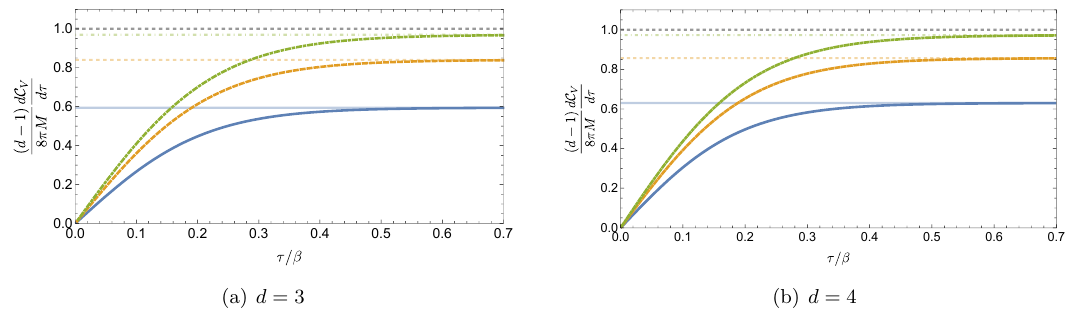
Figure 24 . Plots of d (cid:0) 1 d C V =dt for spherical black holes ( k = 1) for various values of the horizon 8 (cid:25)M radius | r h =L = 1 (blue), r h =L = 2 (yellow), r h =L = 5 (green). At late times, they approach to the asymptotic values indicated in (cid:12)gure 6(a). The asymptotic value at late times is always smaller than 1 and approaches to 1 for large black holes. We can also see that the asymptotic value is always approached from below.